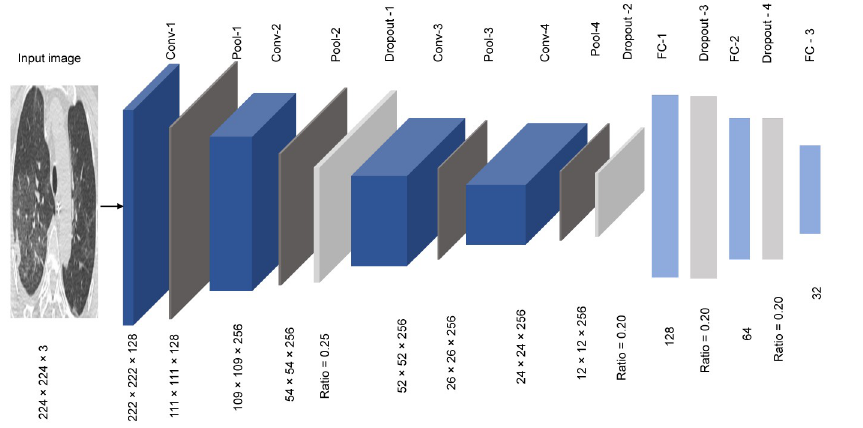
Fig 4. The proposed CNN model for feature